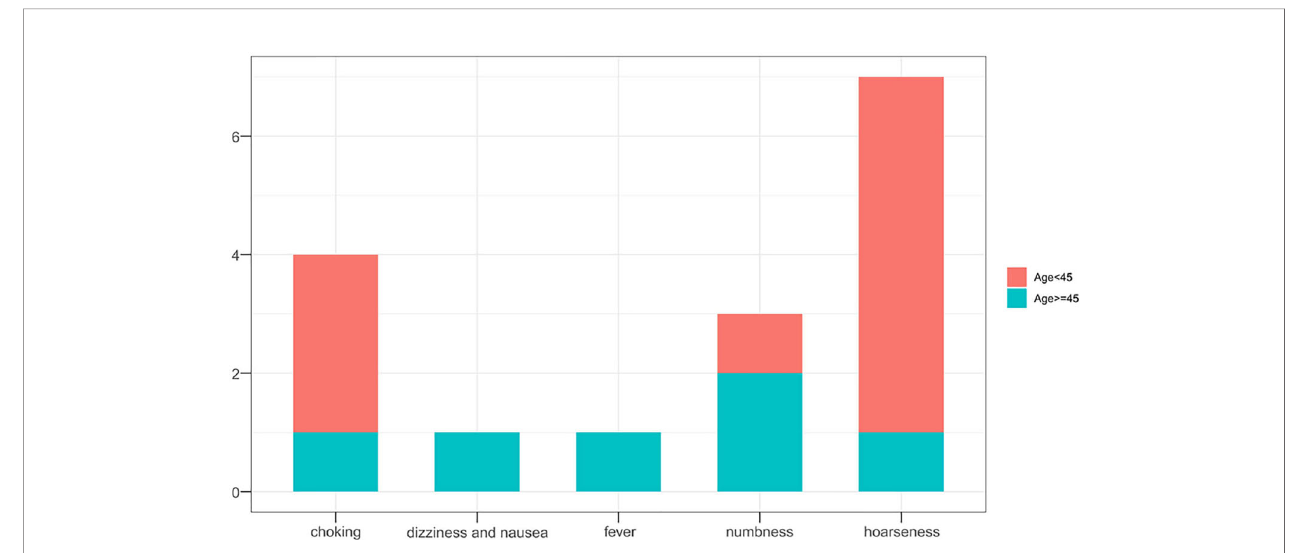
FIGURE 5 | Complication recurrence following surgical resection in both age